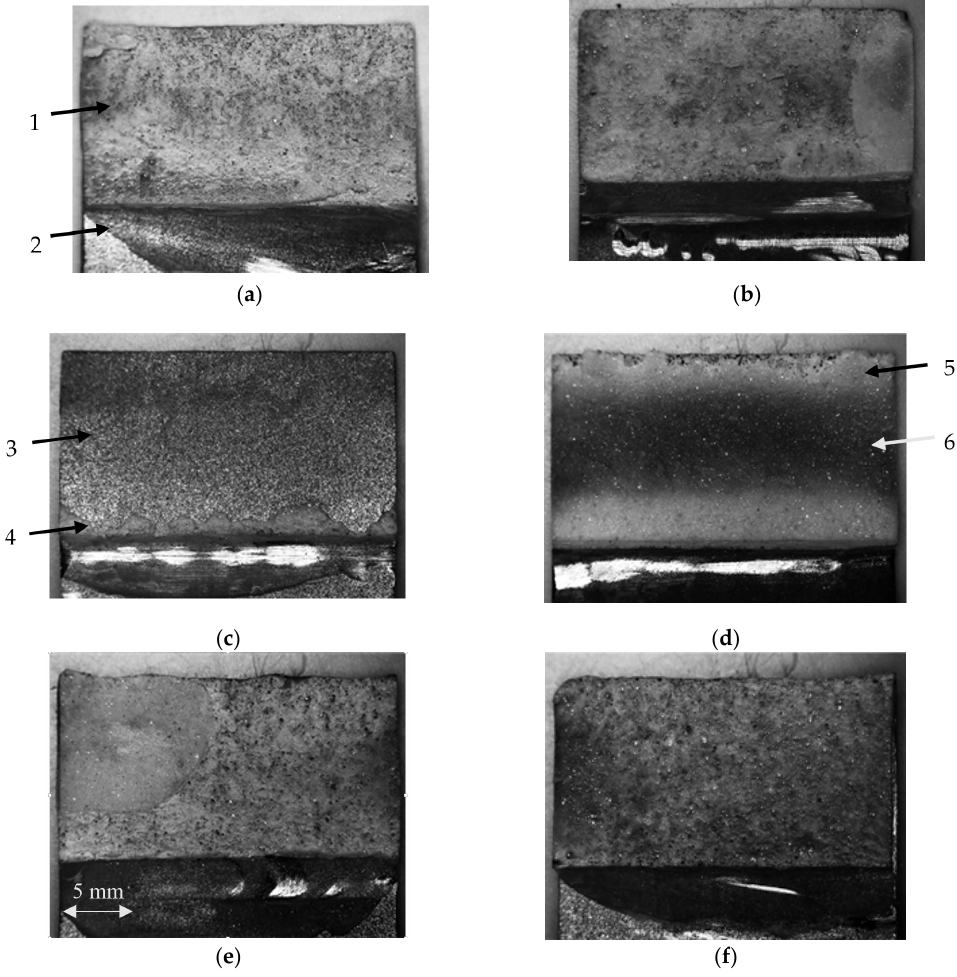
Figure 18. Examples of lap joint failure: ( a ) type A-A exp, ( b ) type S-S exp, ( c ) type S-A exp (aluminium side), ( d ) type S-A exp (steel side), ( e ) type 3-A3 exp, ( f ) type A5-A5 exp.